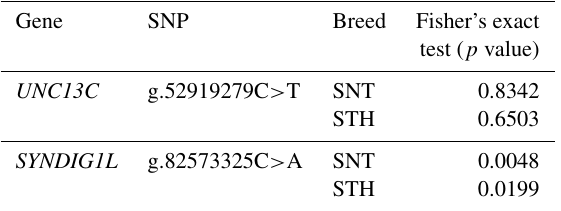
Table 6. Logistic regression for genotypes, breeds, and different thoracic vertebral numbers. Gene SNP